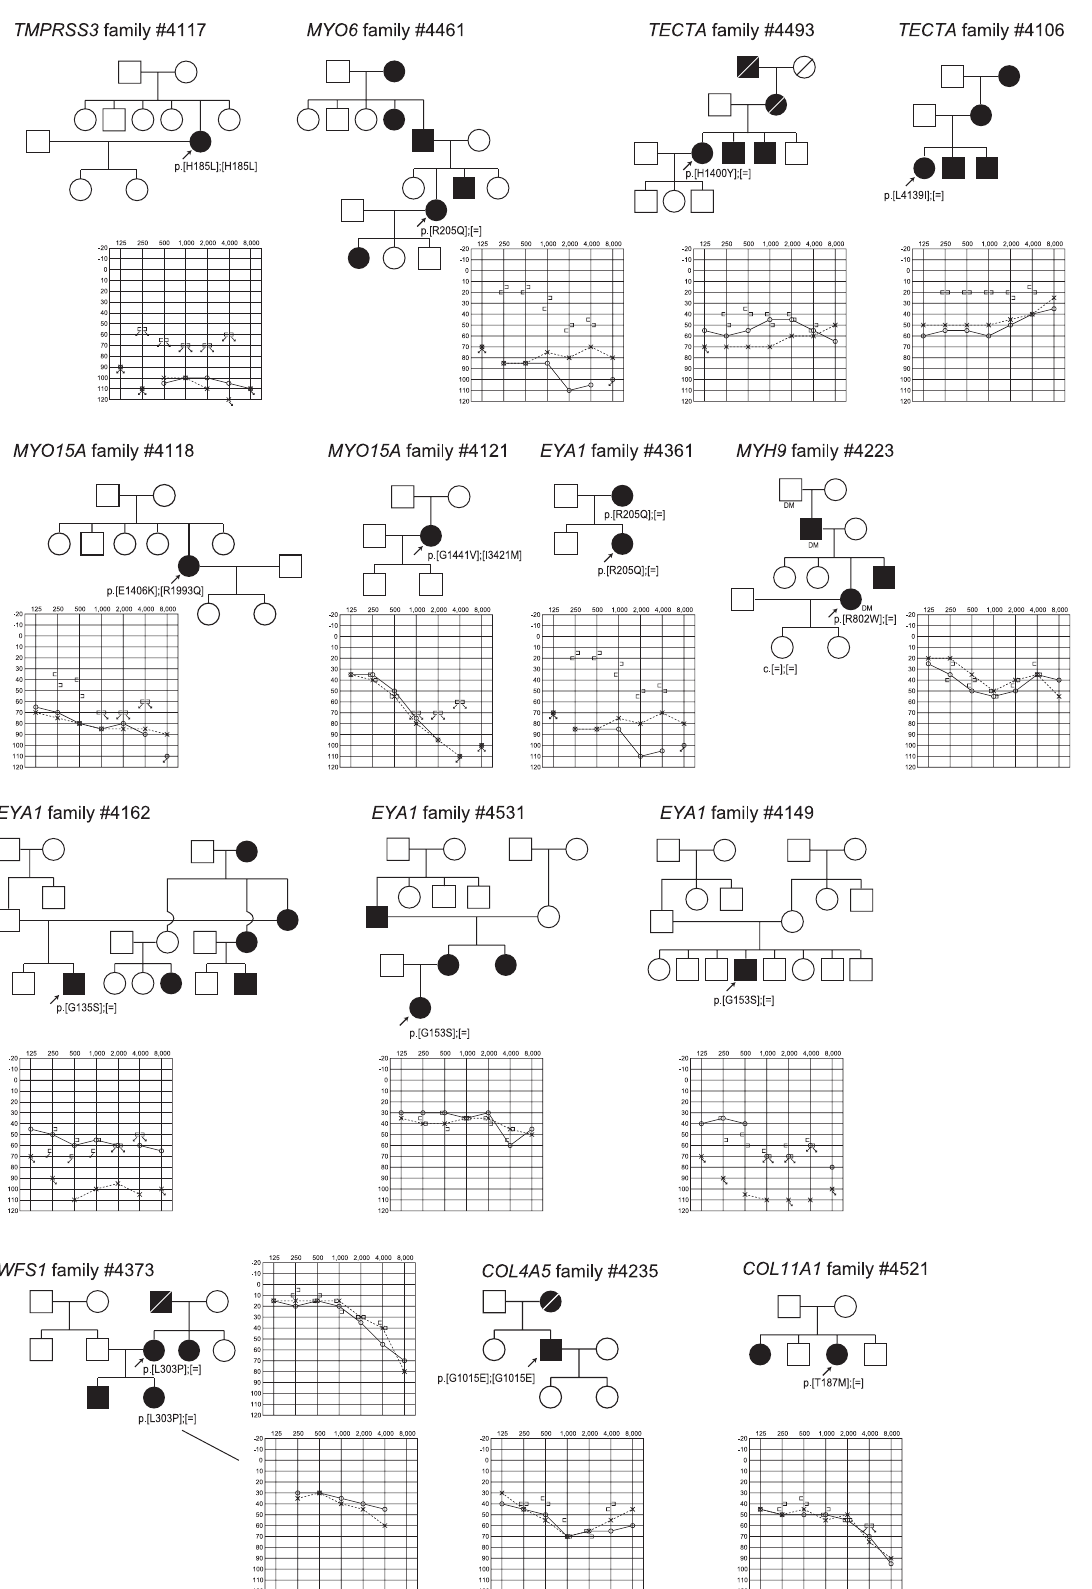
Figure 5. Examples of the families and audiograms of the patients with missense mutations after confirmation by Sanger sequencing.